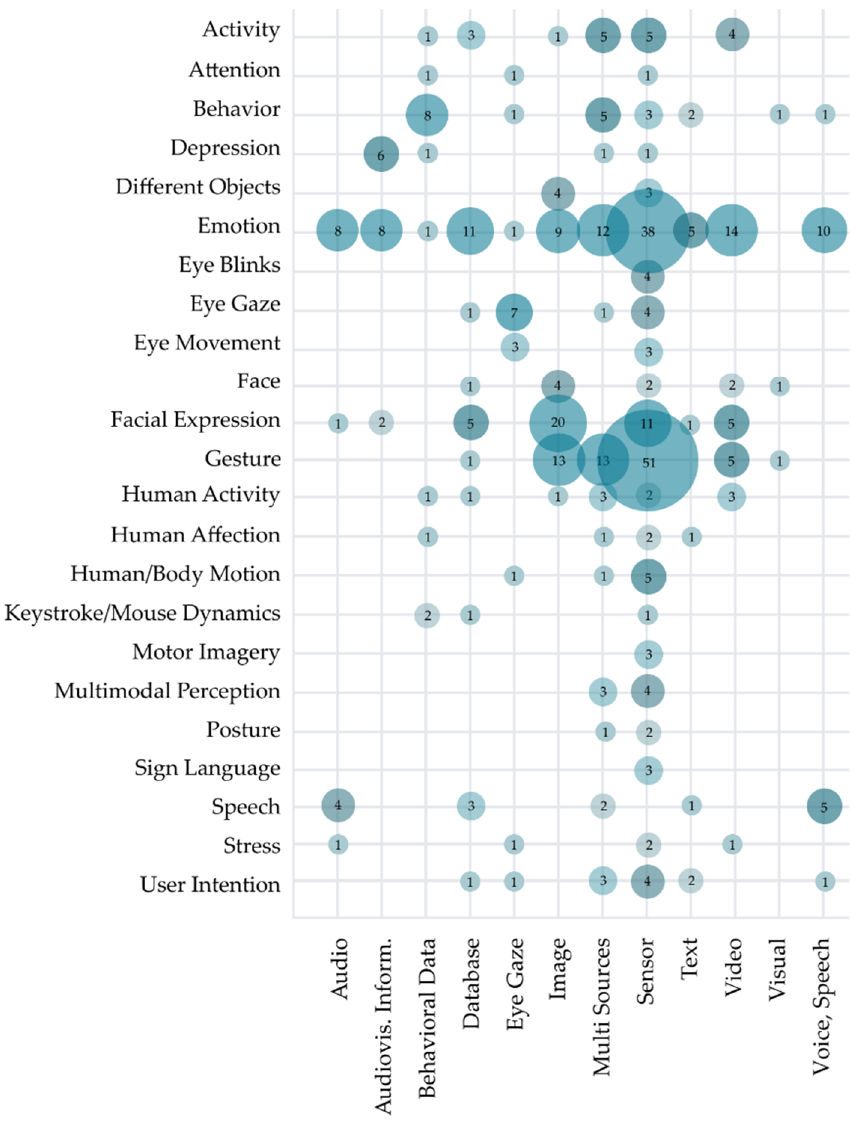
Figure 14. Distribution of data sources in existing HCI recognition solutions. Figure 15 addresses RQ3.1 and RQ3.3, showing the distribution of primary studies